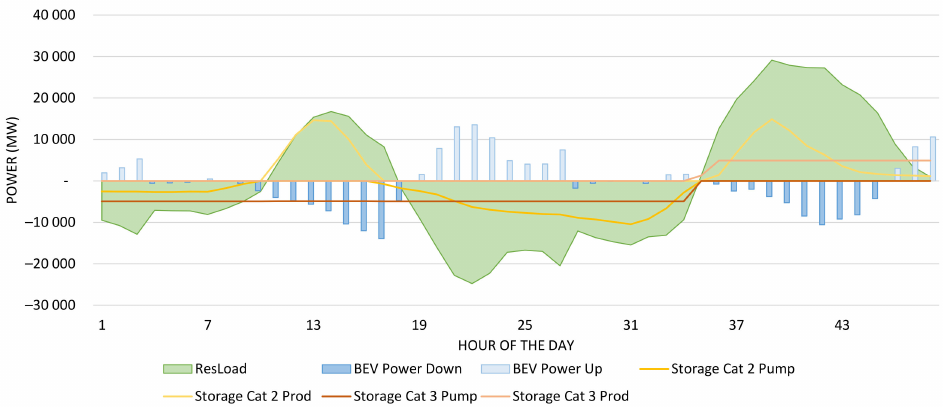
Figure 8. Interaction between the DSI -flexibility (blue/light blue) and the storages (Cat 2 in yel- low/light yellow, Cat 3 in red/light red) to meet the given residual load (green area) for two exemplary days.